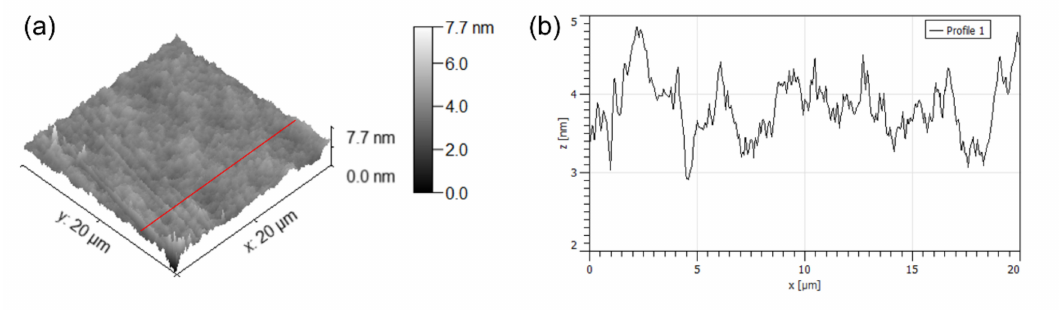
Figure 4. ( a ) Three-dimensional atomic force microscopy (AFM) image and ( b ) profile of the free-standing, UV-casted thiol-ene film. The red line indicates the location where the AFM profile was